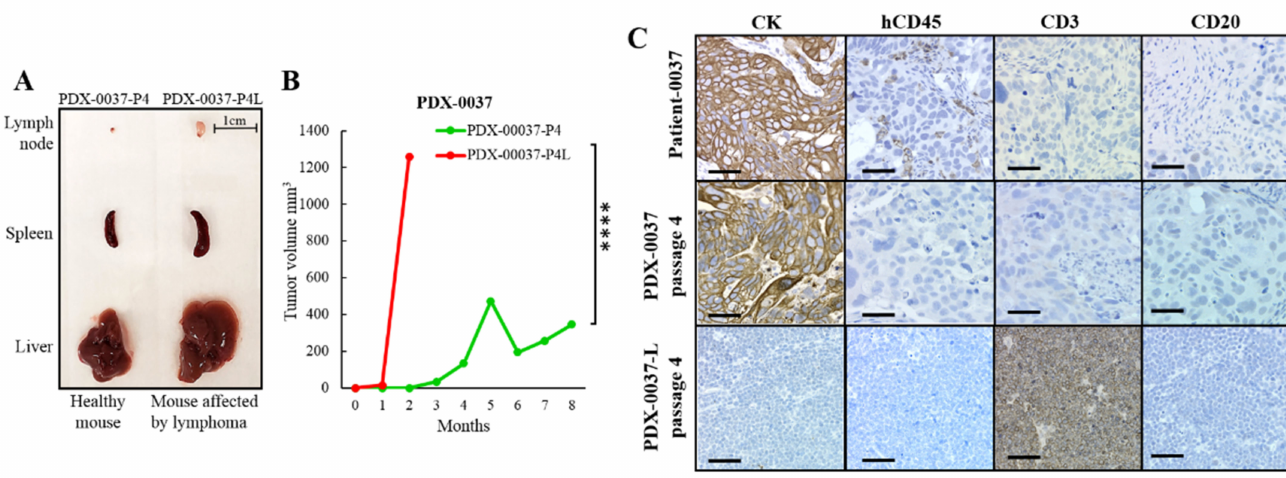
Figure 1. Lymphoma transformation in PDX tumor models. ( A ) Representative photographs of organs collected from a mouse affected by lymphoma vs. healthy control. Macroscopic analysis revealed splenomegaly and enlarged liver and lymph nodes. ( B ) Graph represents tumor growth rate of PDX-0037 with and without lymphoma contamination in NOD/scid mice (one-way ANOVA followed by Tukey’s multiple comparisons test, **** = p < 0.0001). ( C ) Representative sections of lymphoma-contaminated tumor model (PDX-0037-P4L) compared with original patient tumor and the non-affected PDX model (PDX-0037-P4); P4 indicates passage number, L indicates individual animal bearing lymphoma-contaminated PDX. Tumor sections were evaluated by IHC for CK, hCD45, CD3 and CD20 expression. Scale bars represents 50 µ m. For additional information, see Supplementary Figure